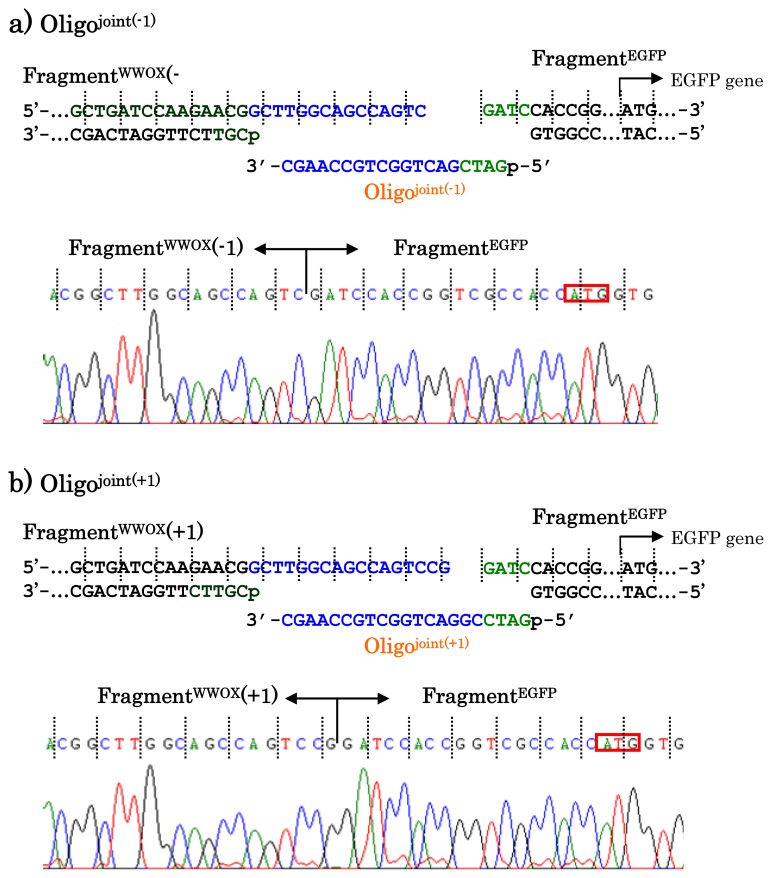
Enzymatic ligation of the ARCUT scission fragments with the FragmentEGFP in the presence of Oligojoint(−1) (a) and Oligojoint(+1) (b).